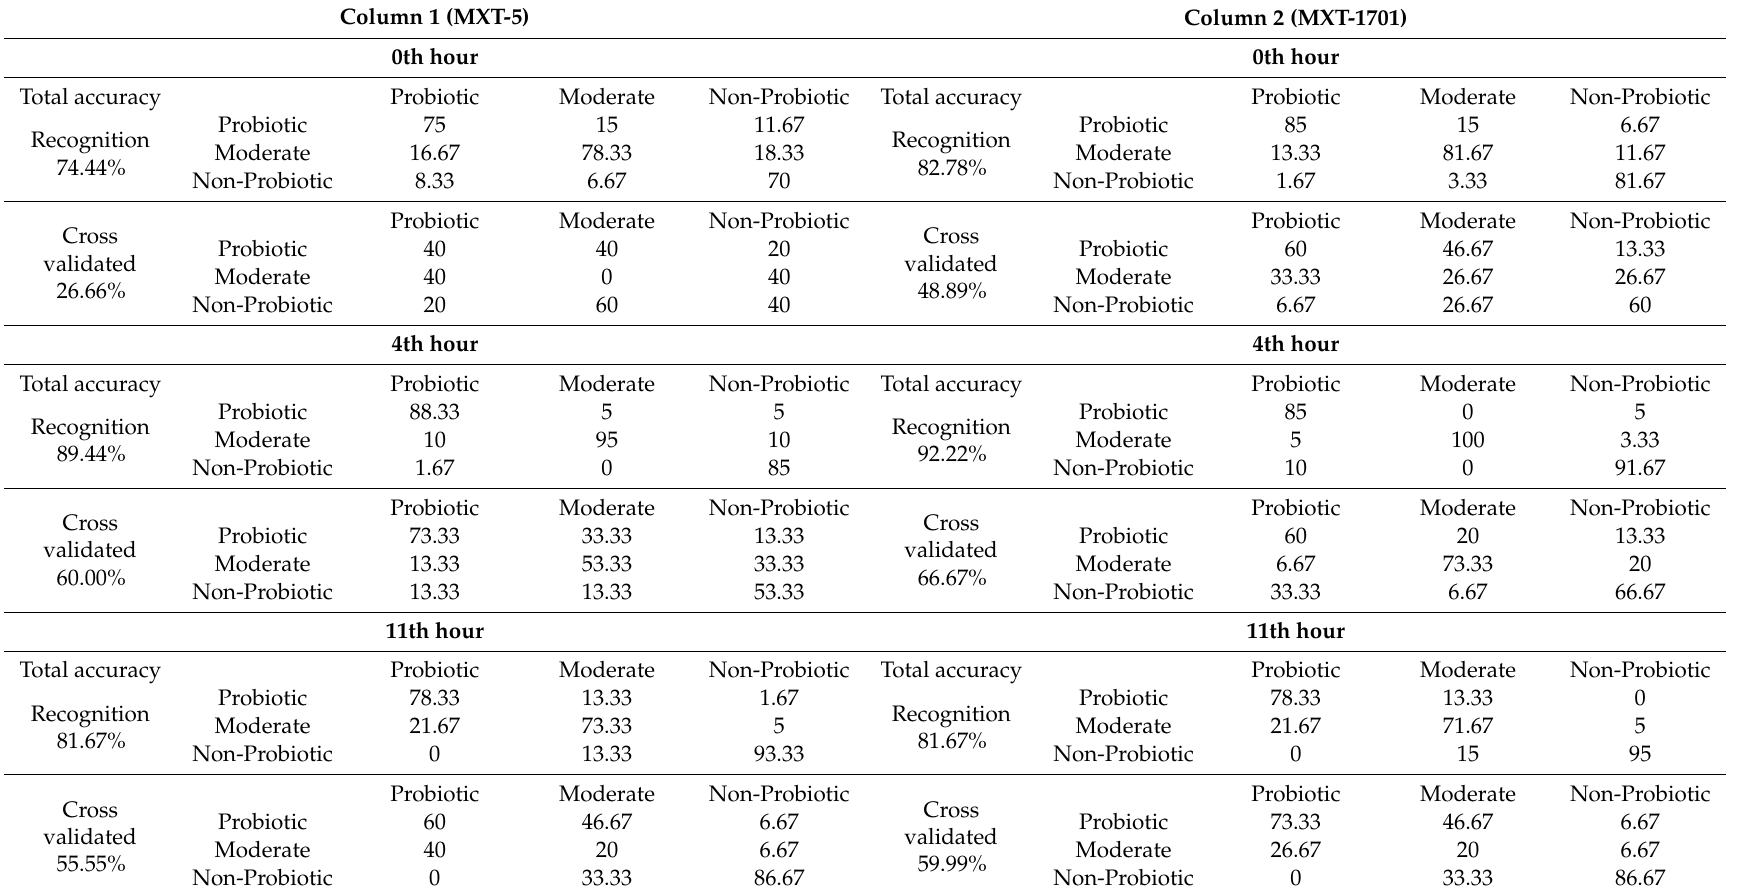
Table 2. Confusion table of the LDA models built for the discrimination of Lactobacillus strains according to their probiotic activity at the 0th, 4th, and 11th hours using the